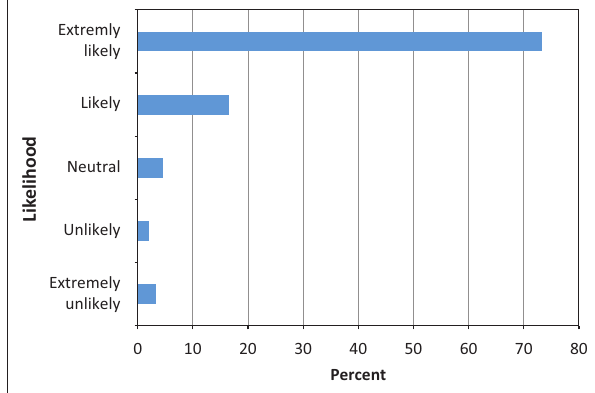
FIGURE 8: Likelihood of using tuk-tuk again.